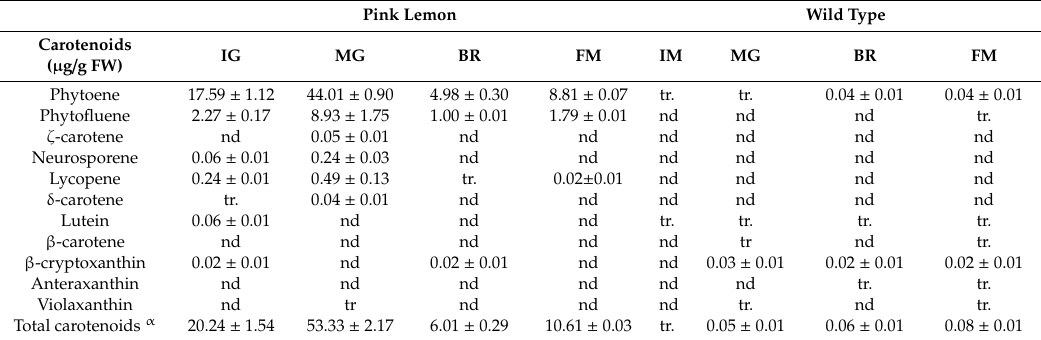
The amount of violaxanthin represents the sum of all-trans and 9-cis isomers. Traces indicate amount lower than 0.01 µ g / g FW. nd: not detected. Tr: traces. Data are expressed as mean ± SD. α Total carotenoids are the sum of the main carotenoids identified and quantified.